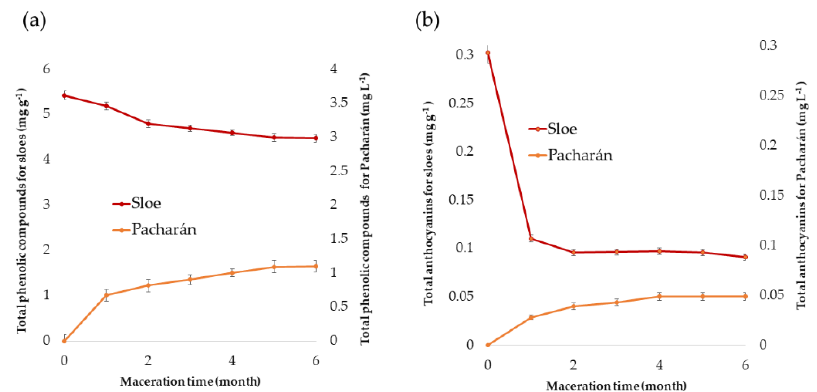
Figure 8. Total phenolic compounds ( a ) and total anthocyanins ( b ) extractions from sloes employed to elaborate “Pacharán” and from the “ Pacharán ” obtained at different months of maceration. Results are expressed as mg g −1 of fresh weight (FW) for sloes and mg L −1 for “ Pacharán ” . All results are expressed as means ± standard deviation (SD) ( n = 3).